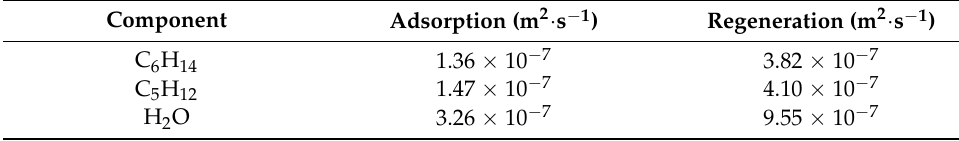
Table 5. Diffusion coefficient of the components.